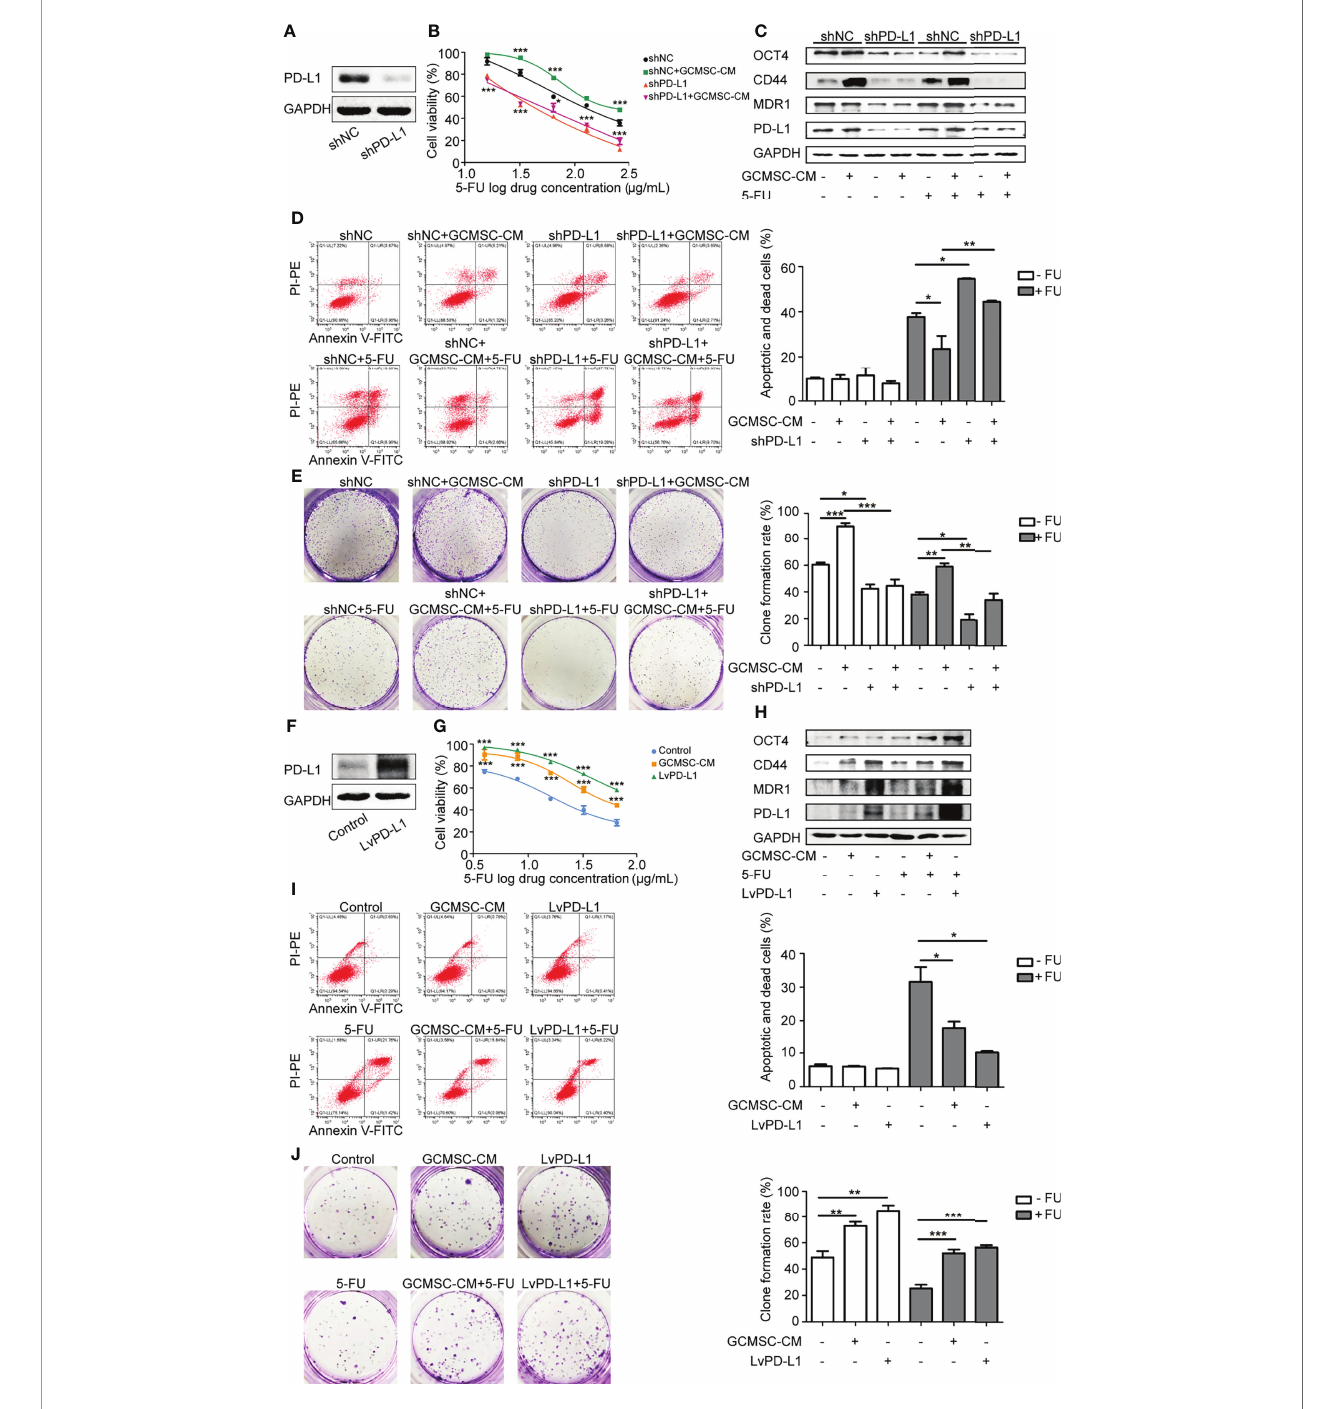
FIGURE 2 | GCMSC-CM increases GC cell stemness by upregulating PD-L1 and leads to chemotherapy resistance. (A) Transfection ef fi ciency of shPD-L1 was tested by Western blot. CCK-8 (B) , Western blot (C) , fl ow cytometry (D) , and colony-forming assay (E) were performed in shPD-L1 SGC-7901 cells following GCMSC-CM and 5-FU treatment. Panels on the right are quanti fi ed images. (F) PD-L1 level in LvPD-L1 HGC-27 cells was tested by Western blot. CCK-8 (G) , Western blot (H) , fl ow cytometry (I) , and colony-forming assay (J) were performed in LvPD-L1 HGC-27 cells following GCMSC-CM and 5-FU treatment. Panels on the right are quanti fi ed images. * p < 0.05, ** p < 0.01, *** p <